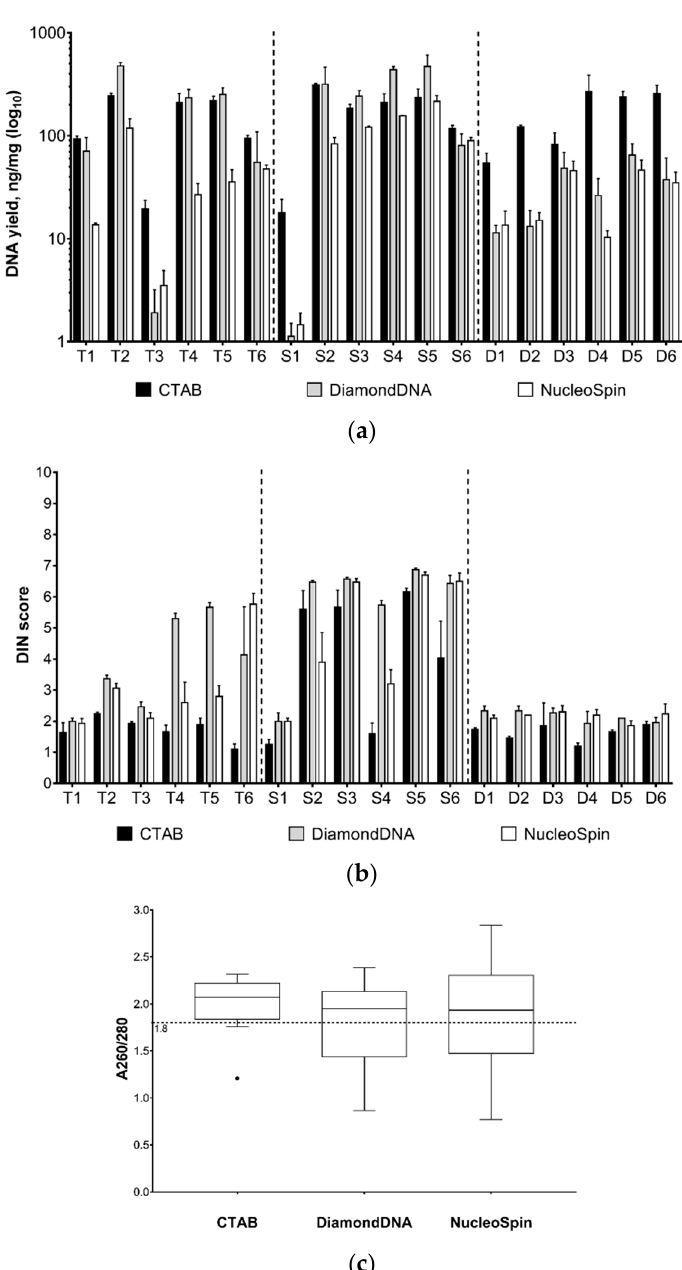
Figure 2. ( a ) Efficacy of DNA isolation from teas (T), spices (S) and herbal mixtures (D) in ng per mg of homogenized sample. The columns represent the mean yield ± standard deviation (SD) ( N = 3). ( b ) Integrity of DNA extracted from teas (T), spices (S) and herbal mixtures (D). The columns represent the mean DIN score ± SD ( N = 3). ( c ) Boxplot (Tukey’s method) of the purity of DNA isolated by different methods according to the spectrophotometric analysis. The dots indicate outliers, and the dashed line indicates an A260/280 ratio of 1.8.